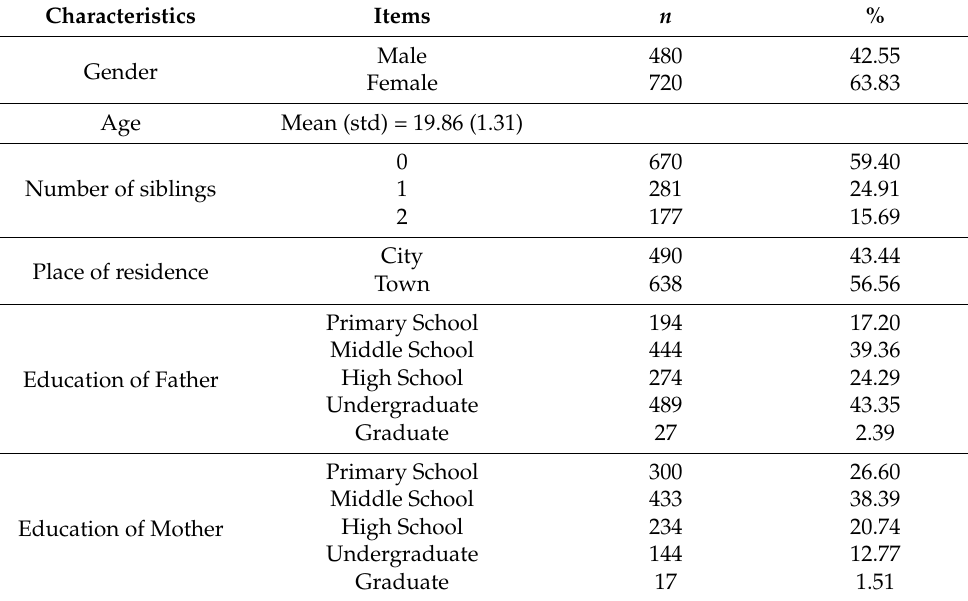
Table 1. Socio-Demographic characteristics of the participants ( n = 1128).